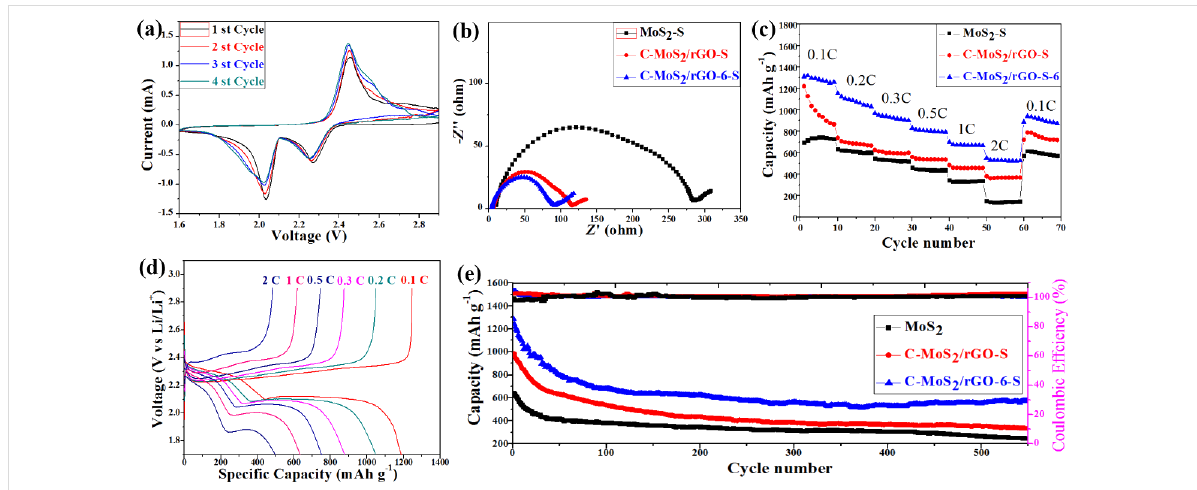
Figure 6: (a) Typical CV curves of the C-MoS 2 /rGO-6-S (b) Nyquist plots of MoS 2 -S, C-MoS 2 /rGO-S and C-MoS 2 /rGO-6-S composites over a fre- quency range 100 kHz to 0.01 Hz. (c) Comparison of rate capabilities at different C-rates for MoS 2 -S, C-MoS 2 /rGO-S and C-MoS 2 /rGO-6-S compos- ites (d) Charge/discharge curves of C-MoS 2 /rGO-6-S at varied C rates (e) Discharge capacities and columbic efficiency for MoS 2 -S, C-MoS 2 /rGO-S and C-MoS 2 /rGO-6-S composites at a rate of 0.2C.